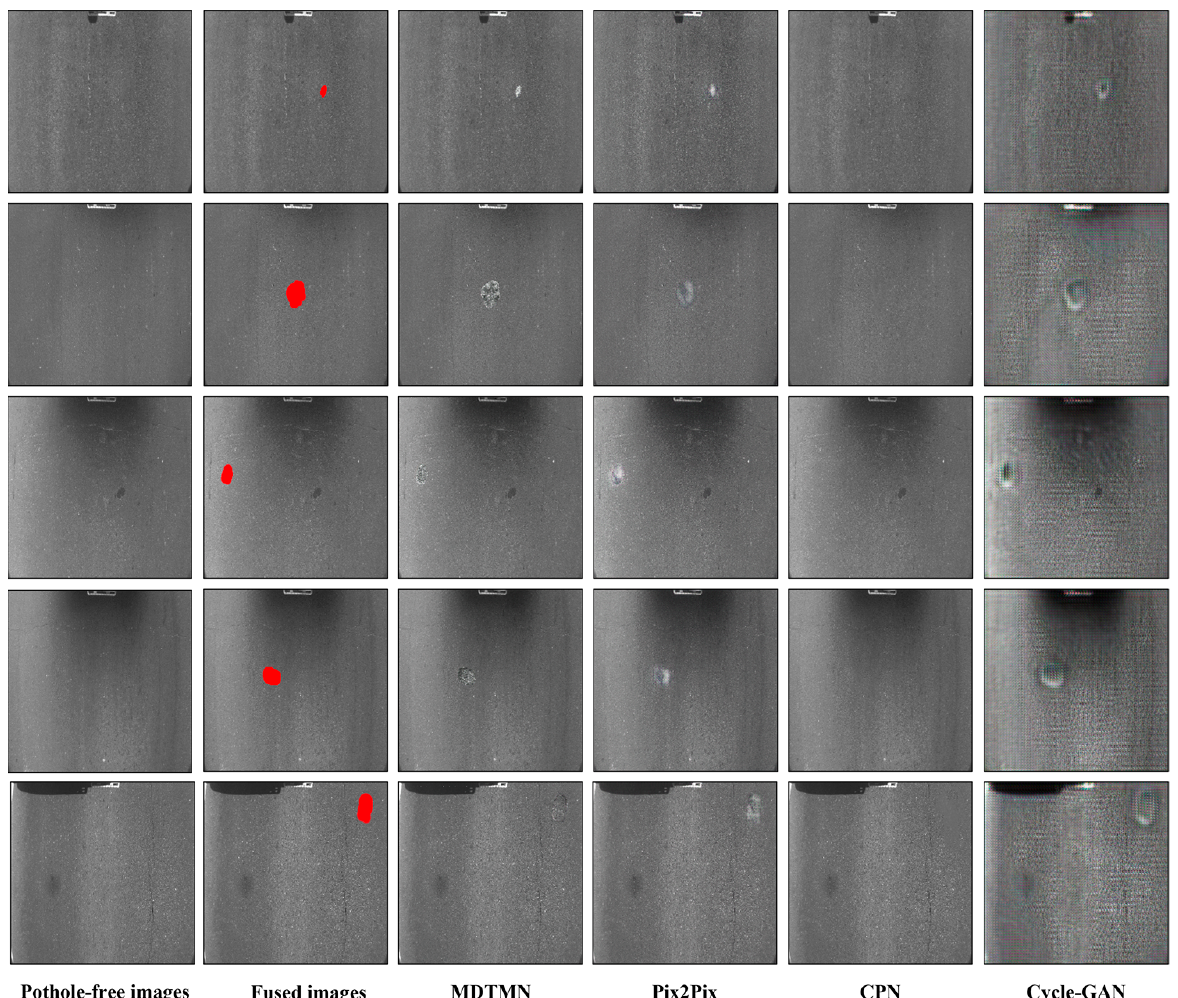
Figure 14. Pothole images generation with pothole-free images. The red marks show the generated pit mask.